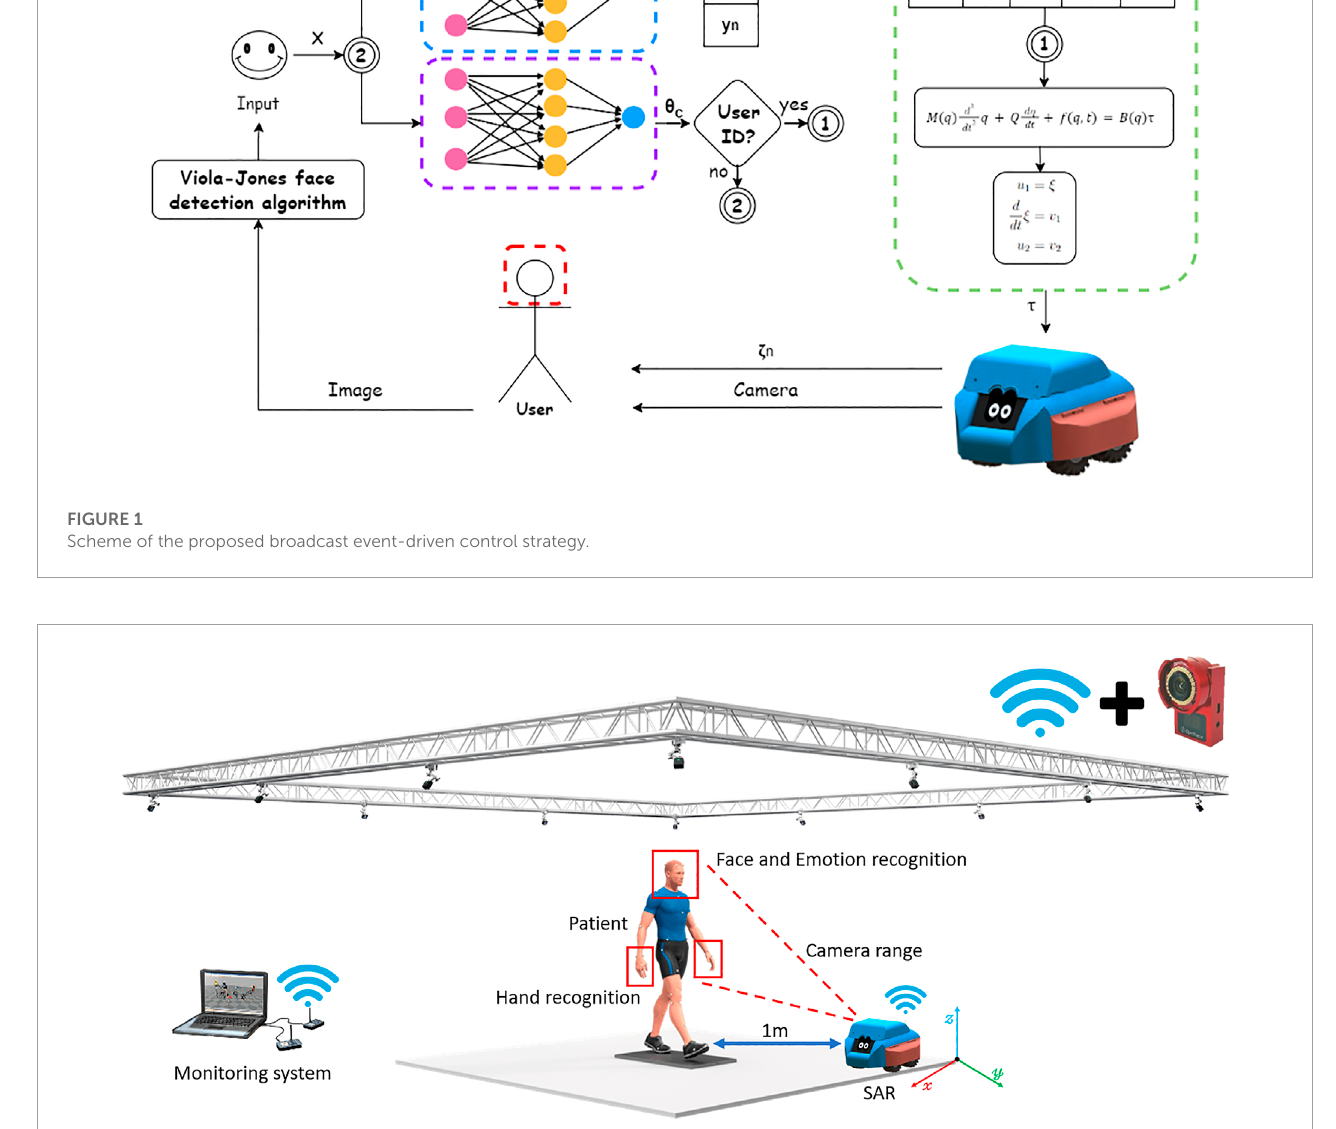
FIGURE 2 Conceptualization of the proposed SAR system. Notice that to avoid the transmission of trash data from the motion-capture system, a minimum of 12 different-sized markers need to be allocated over the surface of both the subject and the SAR by following an asymmetric pattern. This will allow solving three problems: (A) identifying the SAR rear, front, right, and left positions; (B) losing sight of the SAR; and (C) keeping track of the